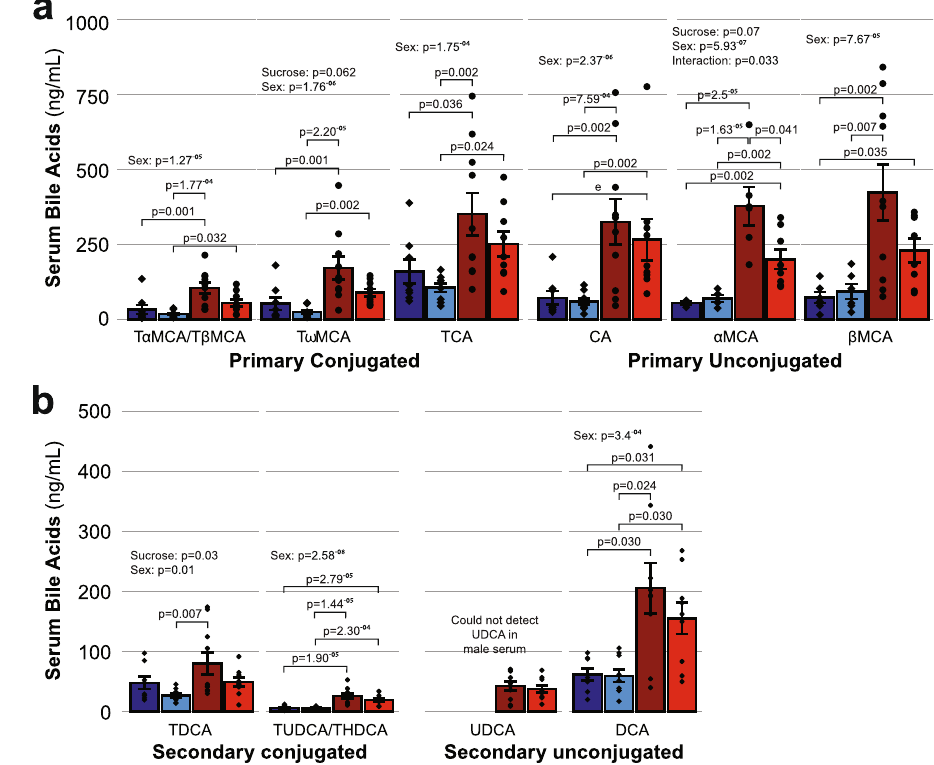
Fig. 5 | Composition of the circulating bile acid pool is in fl uenced by both sex andsucroseintake.a Primaryand b secondaryconjugated andunconjugated bile acids in serum from male and female mice following chronic sucrose intake show sexual dimorphism as determined by two-way ANOVA with post hoc Tukey ’ s test (or Scheirer – Ray – Hare test and post-hoc Wilcoxon Rank Sum test with continuity correction for DCA, which demonstrated a non-parametric distribution). T α MCA/ T β MCA:combinedtauro- α -muricholicacid/tauro- β -muricholicacid(MC: n